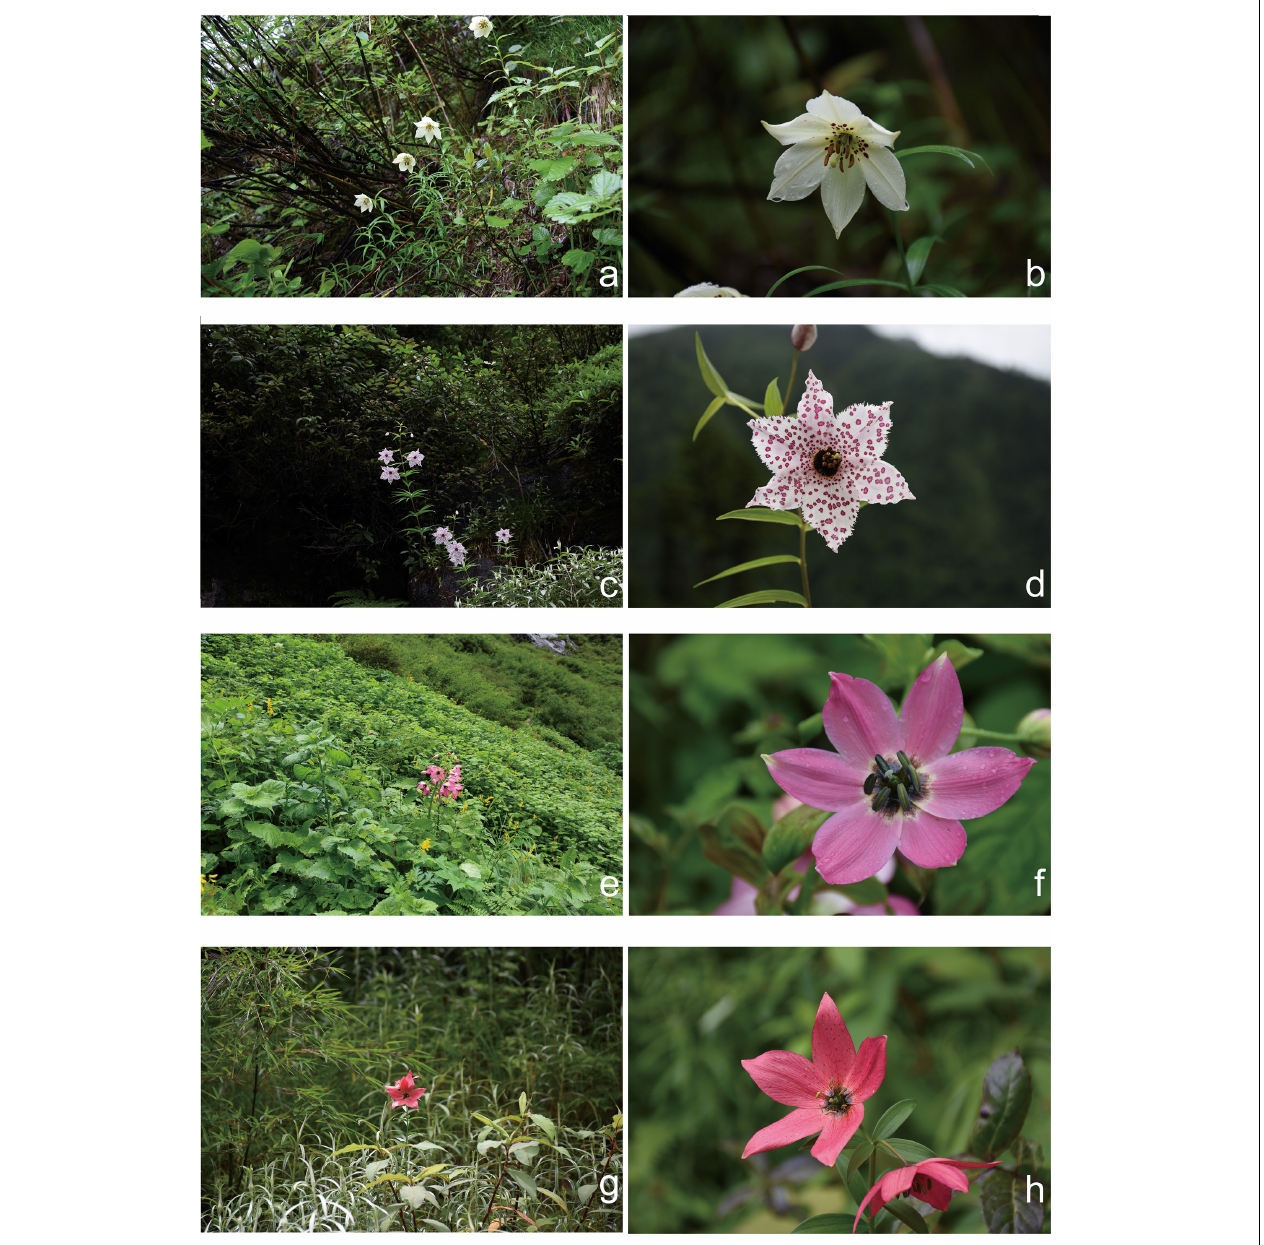
FIGURE 2 | Typical habits of taxa in present study. (a,b) Lilium gongshanense ; (c,d) L. meleagrinum ; (e,f) L. saluenense ; (g,h) possible F2 hybrid between L. saluenense and L. gongshanense .